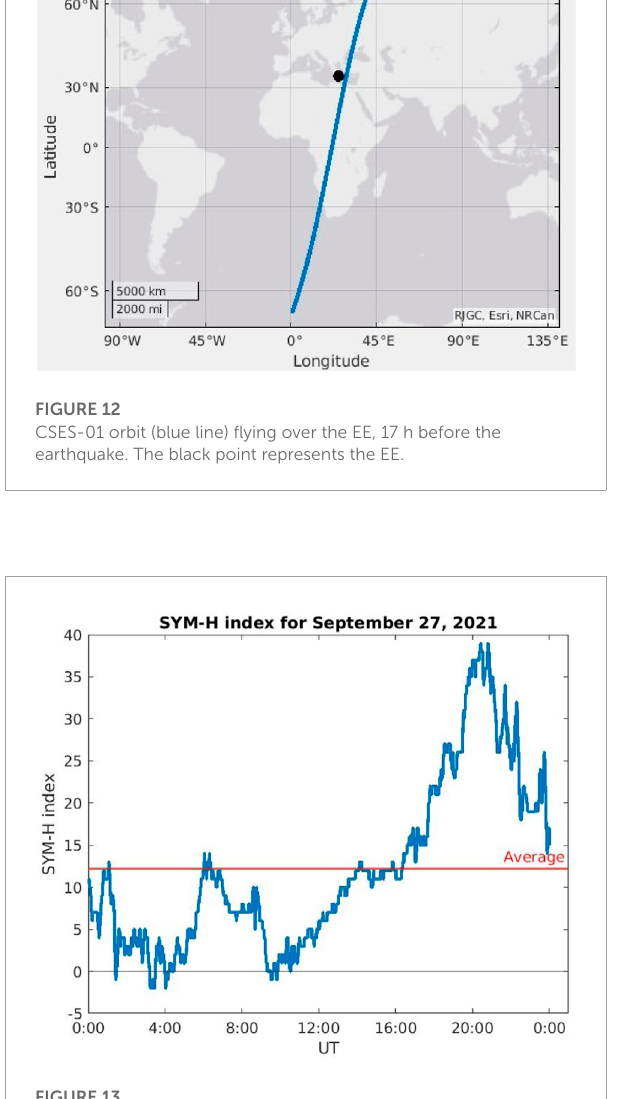
FIGURE 13 SYM-H index for September 27, 2021. This day is classified as